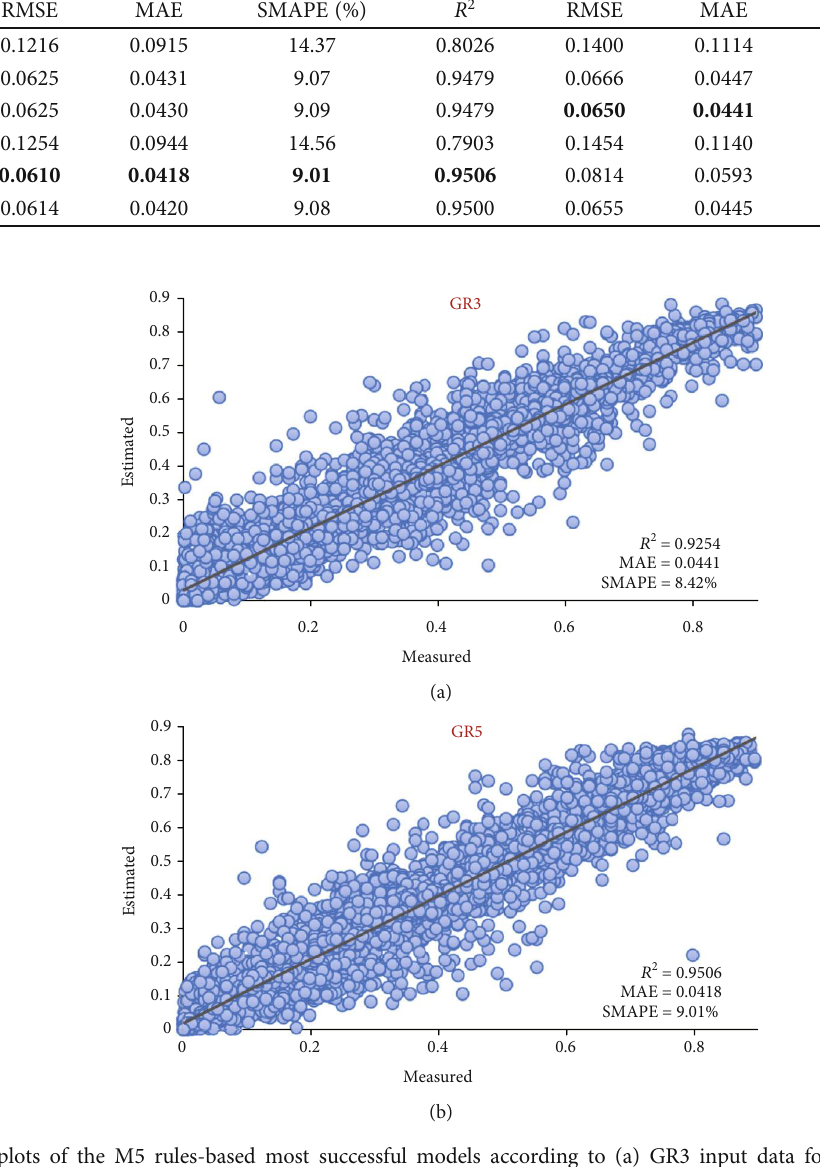
Table 11: Estimation results of the two most successful models that were developed by using the M5 rules algorithm according to input data groups of both provinces. Data